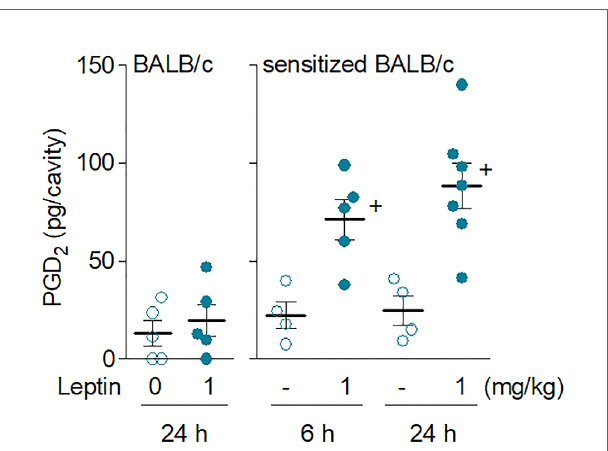
FIGURE 3 | Leptin administration in vivo elicits rapid secretion of PGD 2 in sensitized BALB/c mice. Leptin (1 mg/kg; i.pl.) was injected in naïve (left panel) or sensitized BALB/c mice (right panel). PGD 2 levels found 6 or 24 h (as indicated) after leptin stimulation in pleural fl uids were evaluated as described in Methods. Values are expressed as the mean ± SEM. + p < 0.05 compared to control